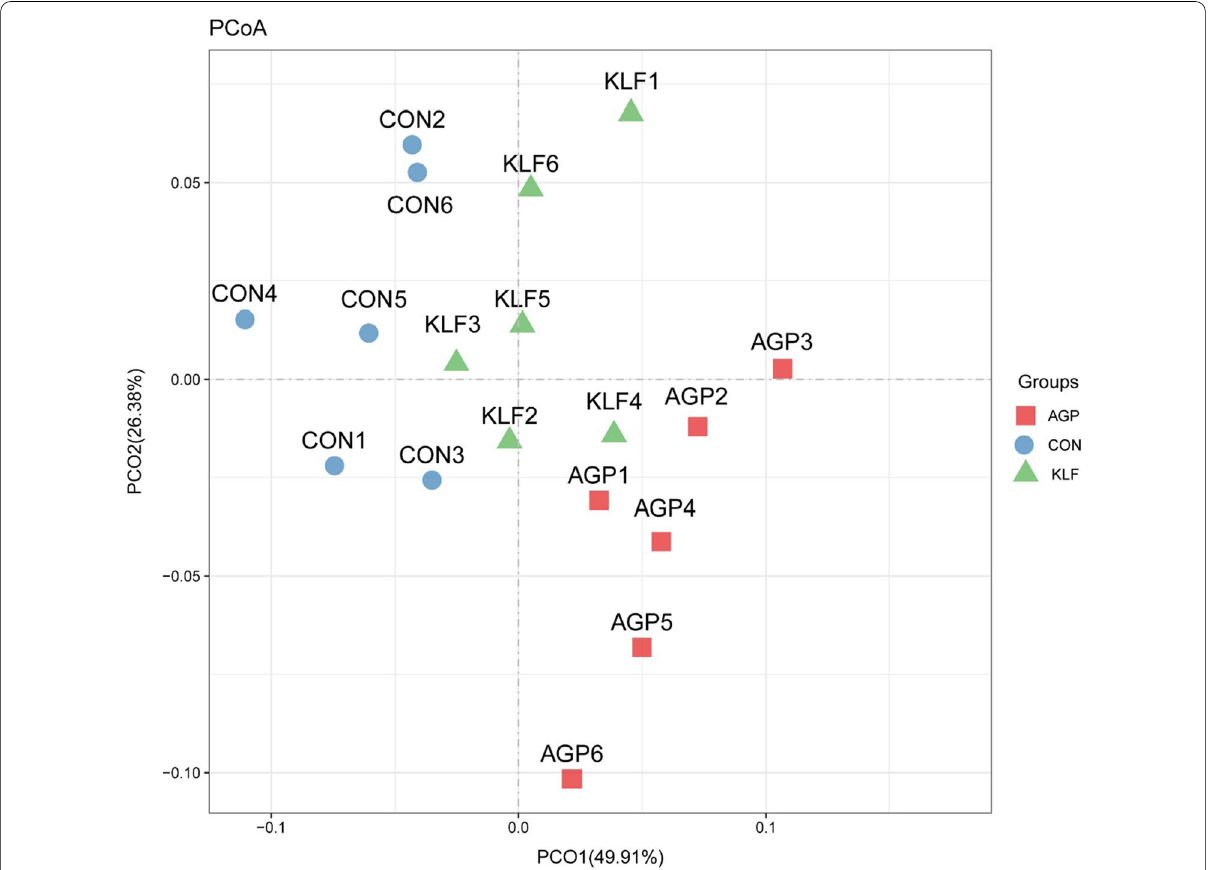
Fig. 2 Principal coordinate analysis (PCoA) on community structures of the cecal microbiota in the different treatments. CON control treatment; KLF kudzu-leaf flavonoids supplement treatment, and AGP the antibiotic supplement (Aureomycin)